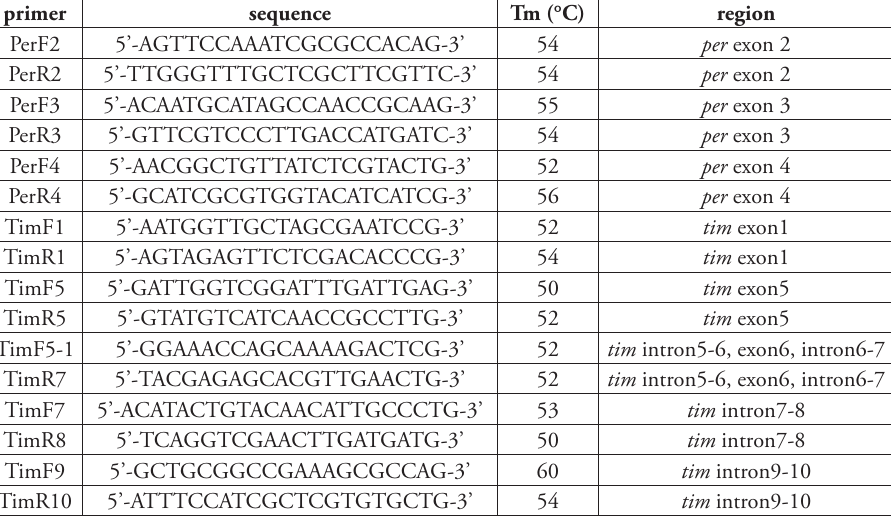
Table 1. Primers constructed to study the genes per and tim